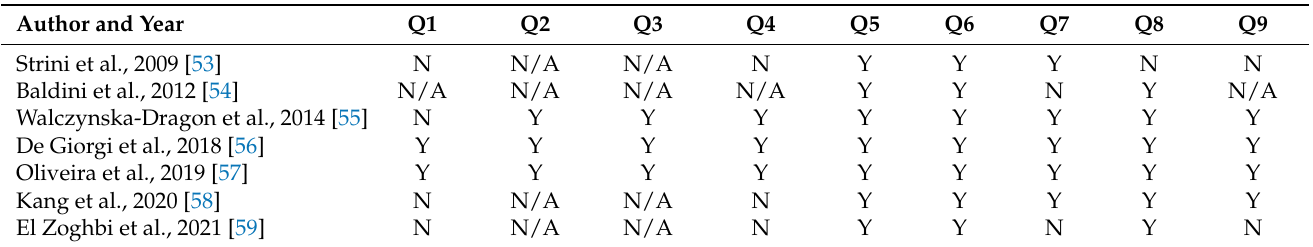
Table 4. Joanna Briggs Institute Critical Appraisal Checklist for Quasi-Experimental Studies (non- randomized experimental